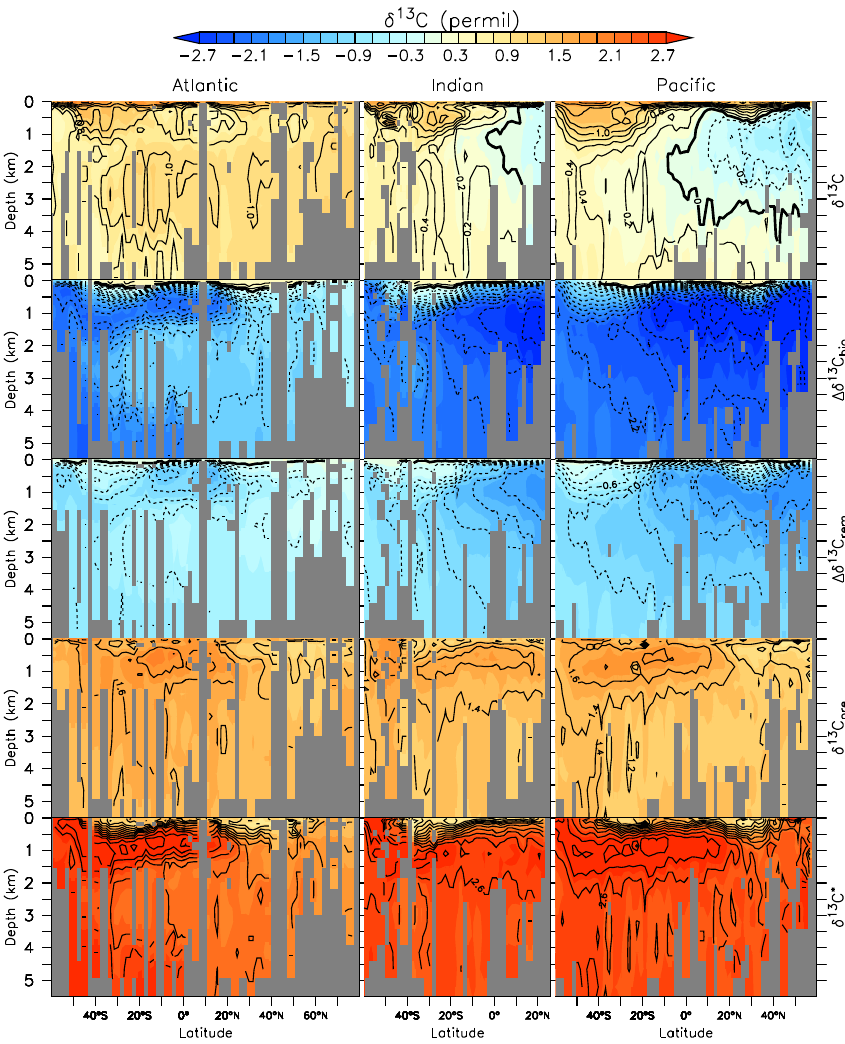
Fig. 11. As Fig. 6 but for the observations representing the